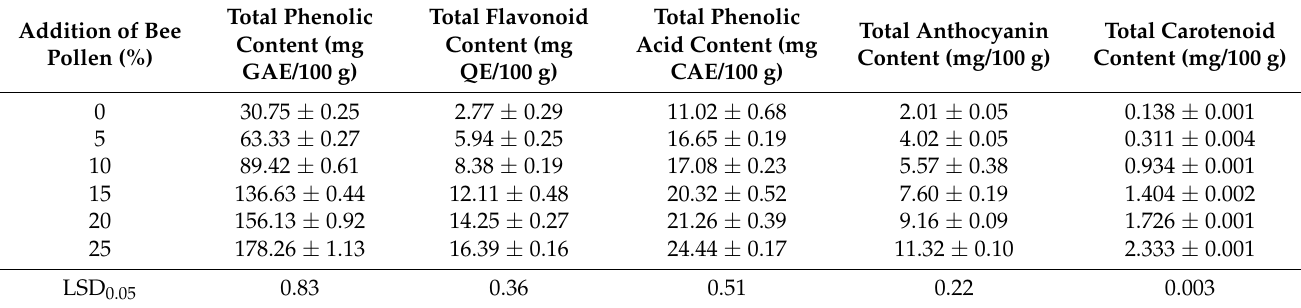
Table 1. The total phenolic, flavonoid, phenolic acid, anthocyanin, and carotenoid content in multiflower honey and honeys enriched with bee